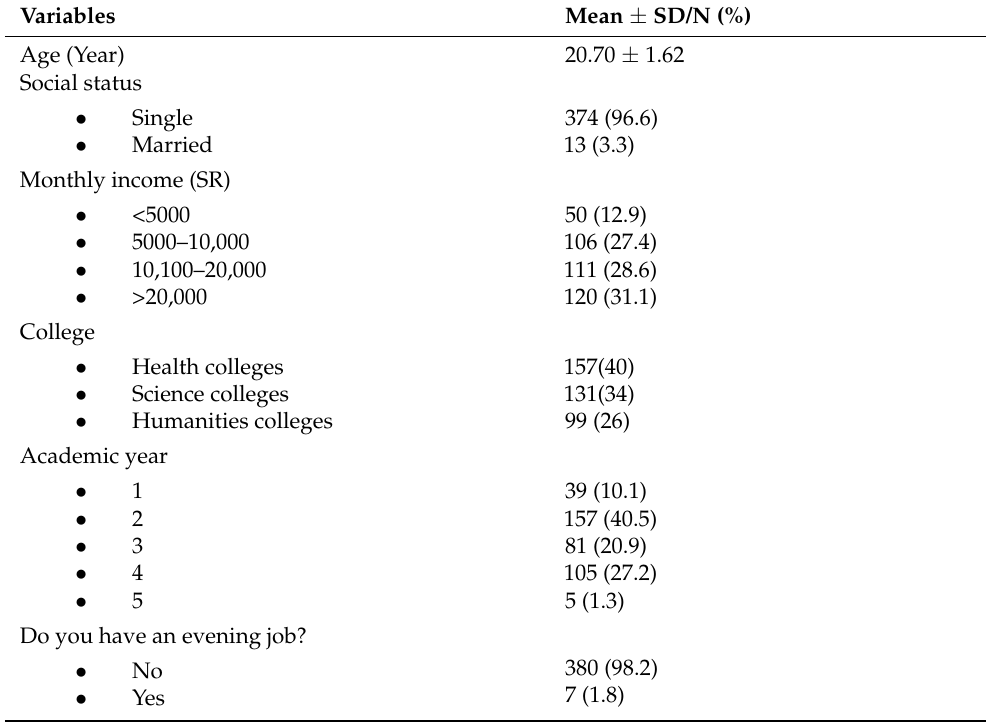
Table 1. Characteristics of the study participants (n =